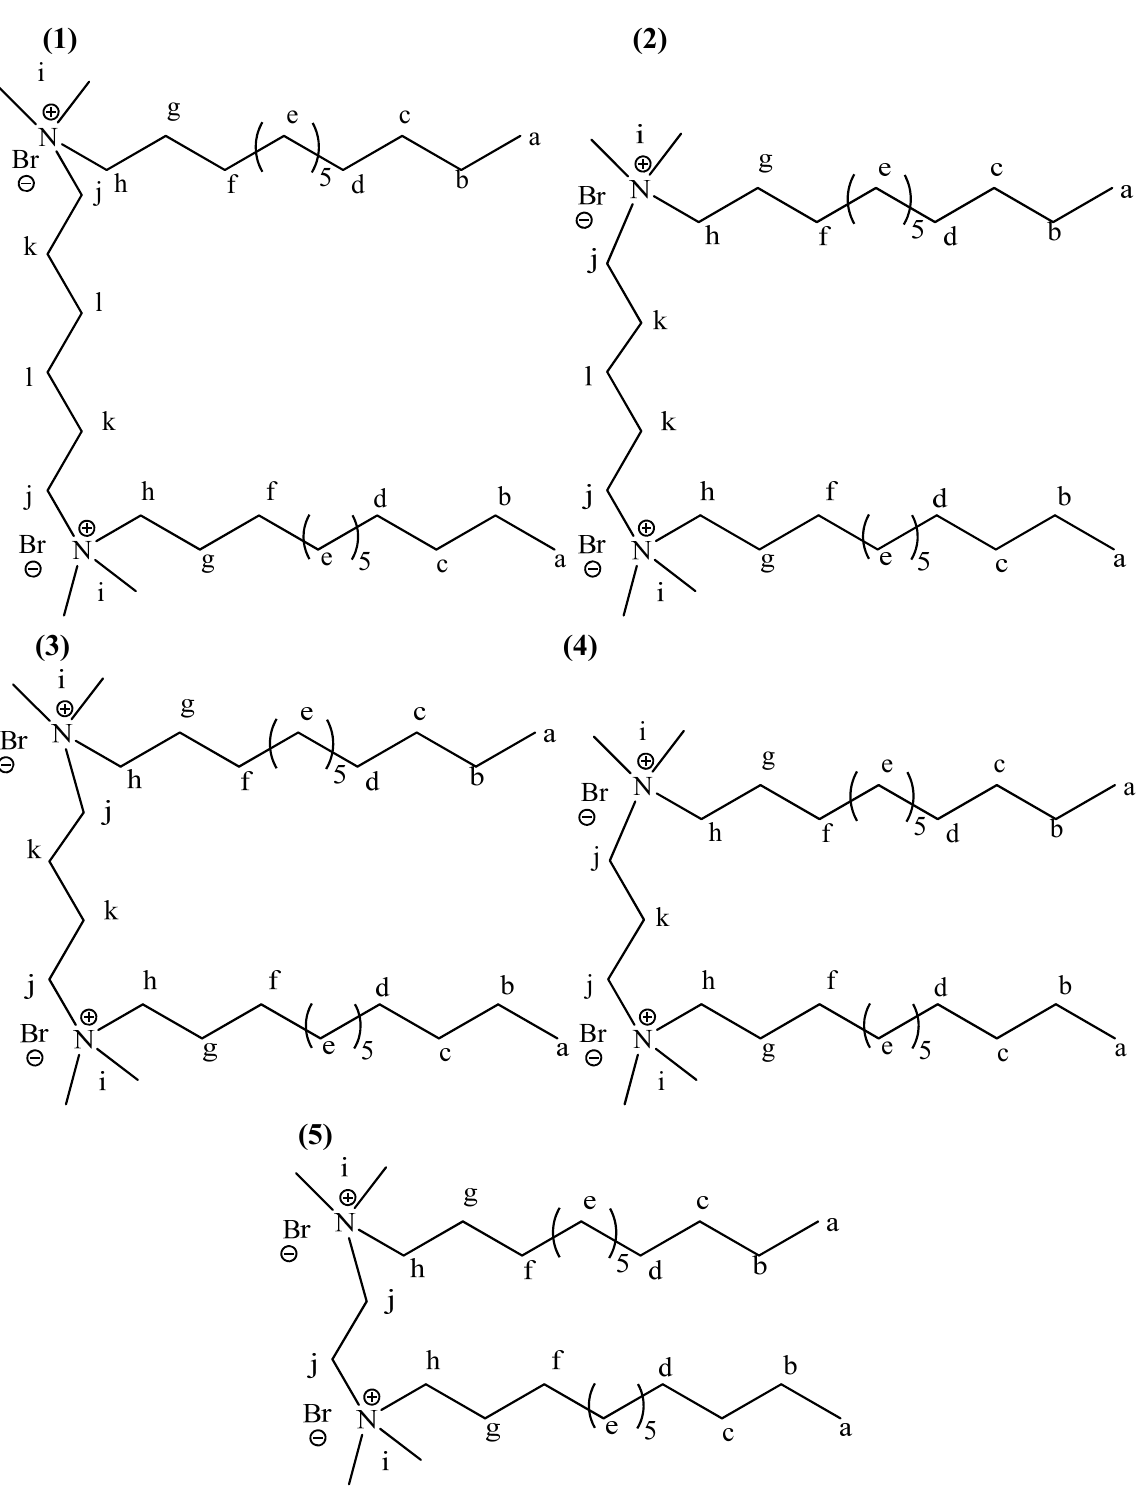
Figure 2. Structures and numbering of hexamethylene-1,6-bis( N,N -dimethyl- N -dodecyl- ammonium bromide) ( 1 ), pentamethylene-1,5-bis( N,N -dimethyl- N -dodecylammonium bromide) ( 2 ), tetramethylene-1,4-bis( N,N -dimethyl- N -dodecylammonium bromide) ( 3 ), trimethylene-1,3-bis- N,N -dimethyl-N-dodecylammonium bromide) ( 4 ) and